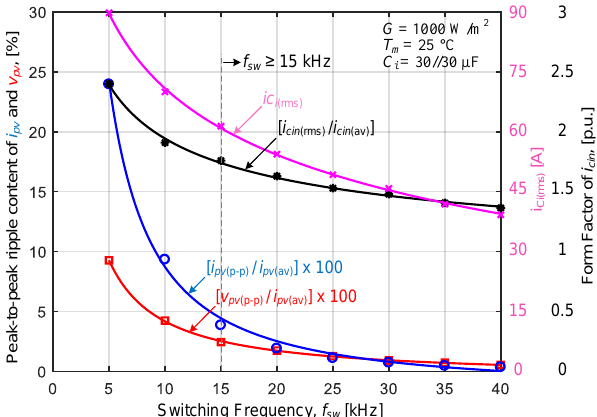
Figure 15. The variations in peak-to-peak ripple contents of i pv and v pv , i Ci ( rms ) , and form factor of i cin as a function of switching frequency ( i pv , v pv , i Ci , and i cin are as defined in Figure 3a; these results were obtained by using the dynamic model in Figure 5b for the standard test conditions marked on the figure; DC link capacitance of the H-bridge converter in the MPPT converter is assumed to be C i = 30 //30 μF).